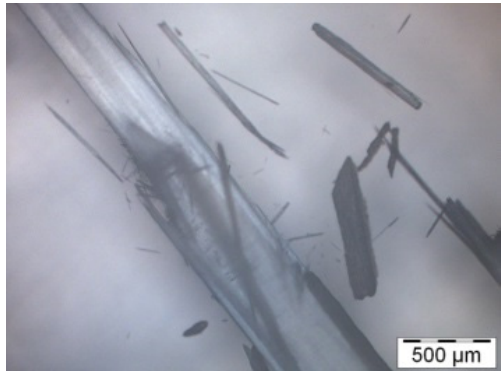
Figure 14. α -HH out of DH after 1 min of hydration.